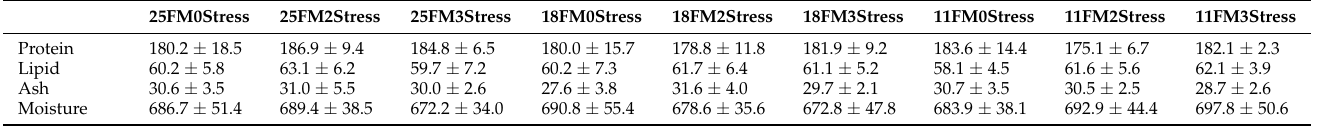
Table 5. Carcass chemical composition (g/kg) of oscar ( Astronotus ocellatus ) fed experimental diets fish meal replacement with meat and bone meal and subjected to varying numbers of